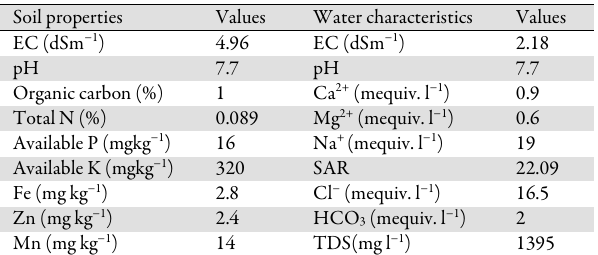
Table 2. Physico-chemical properties of the soil and characteristics of water used for irrigation and foliar